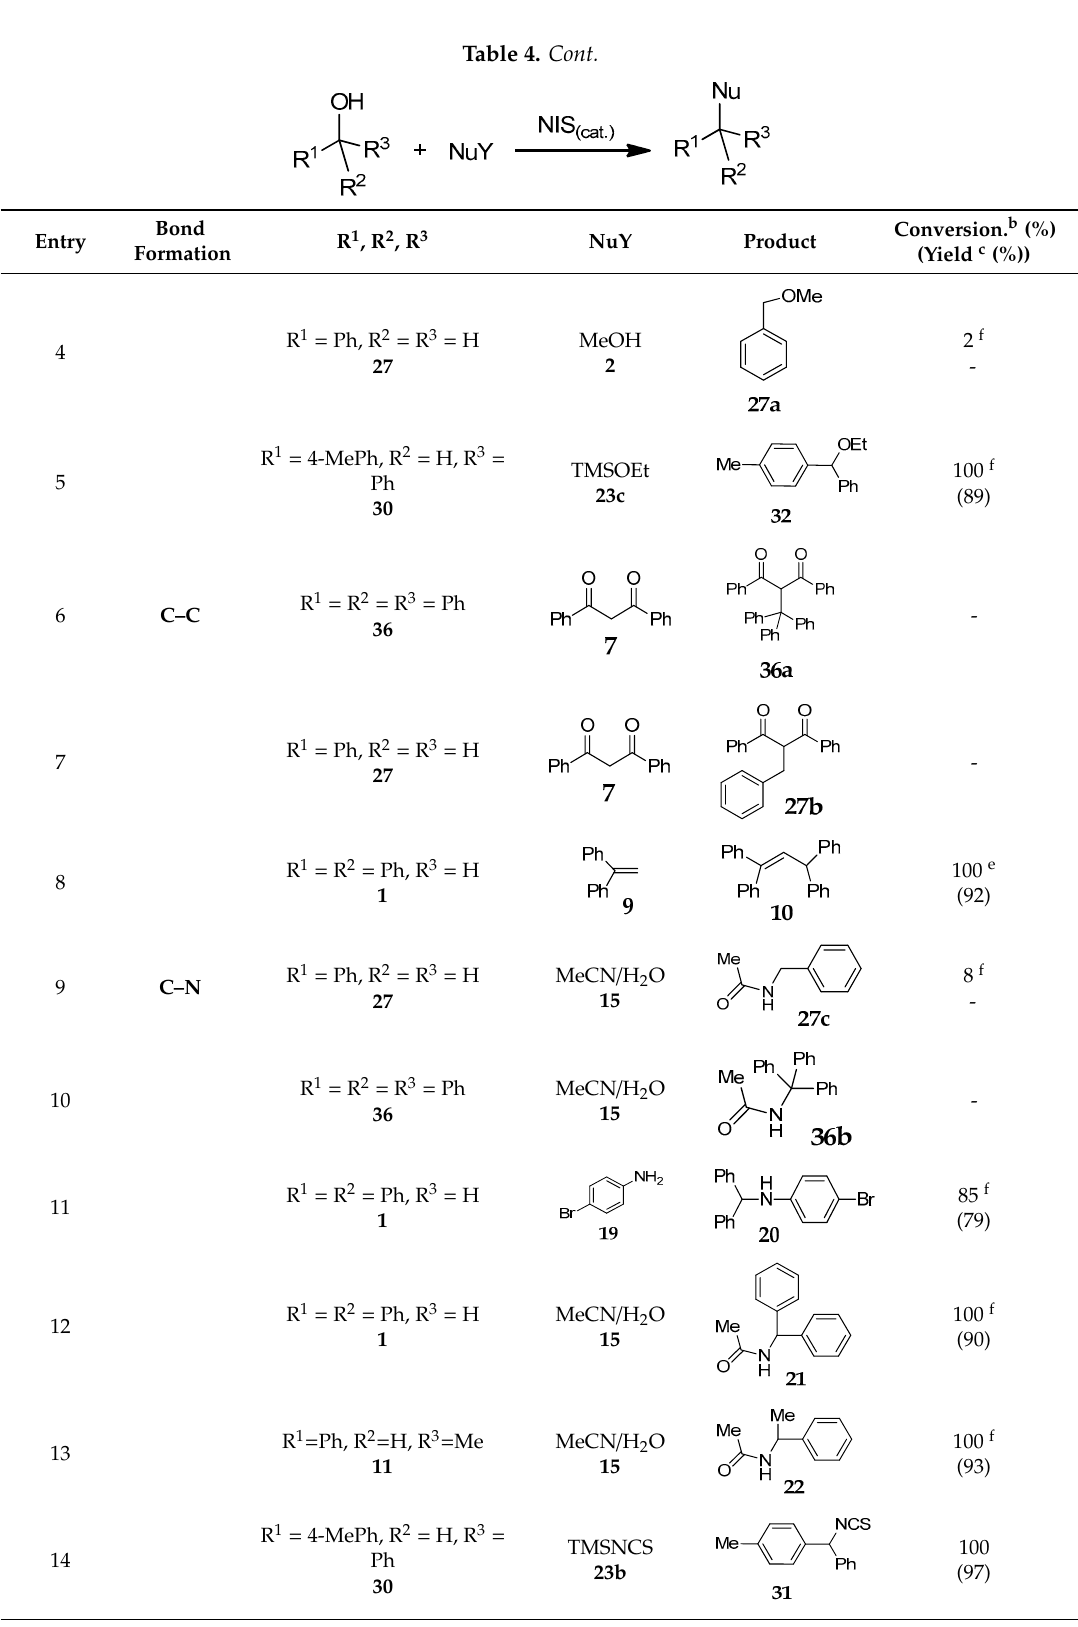
Table 4. Nucleophilic substitution of alcohols using NIS mediator Table 4. Cont.